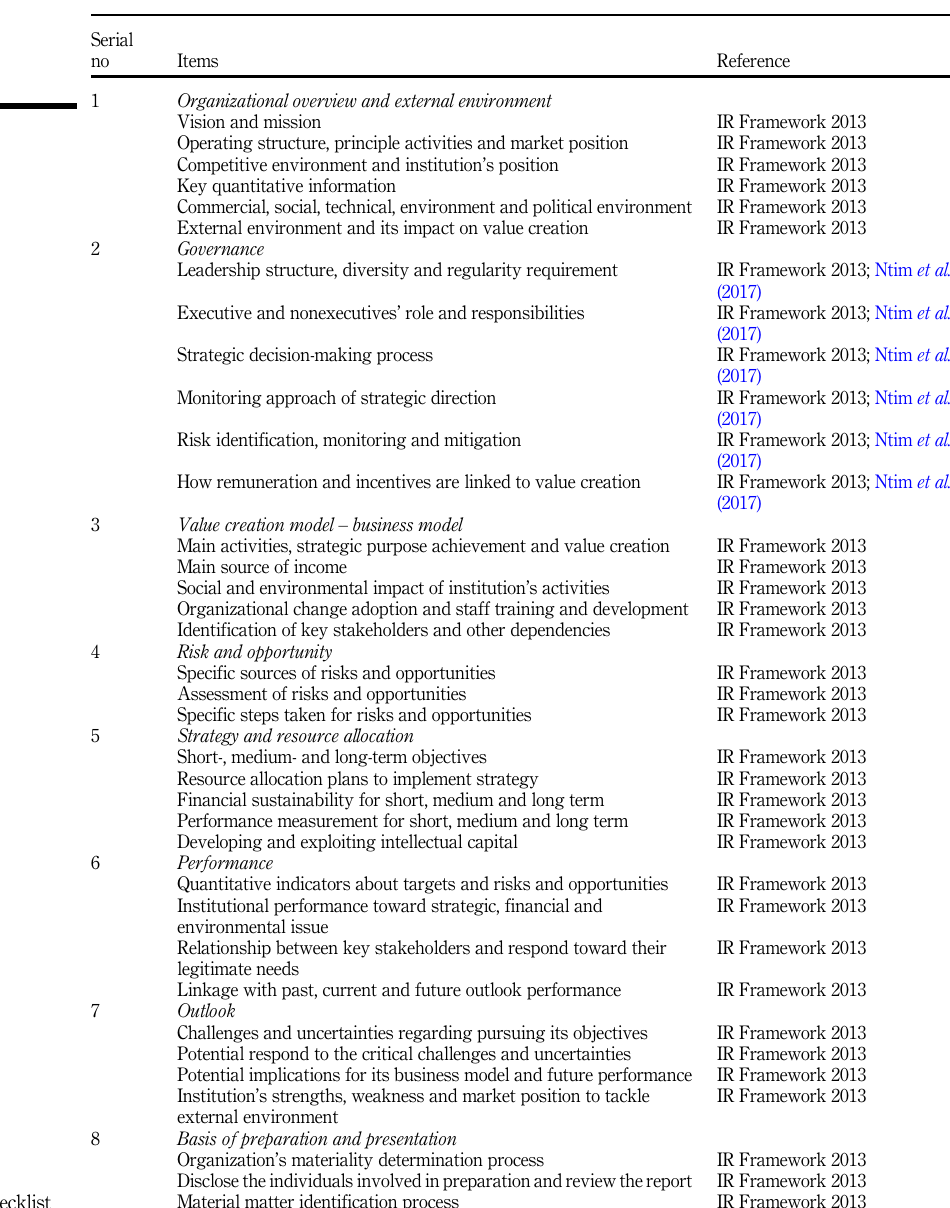
IR Framework 2013